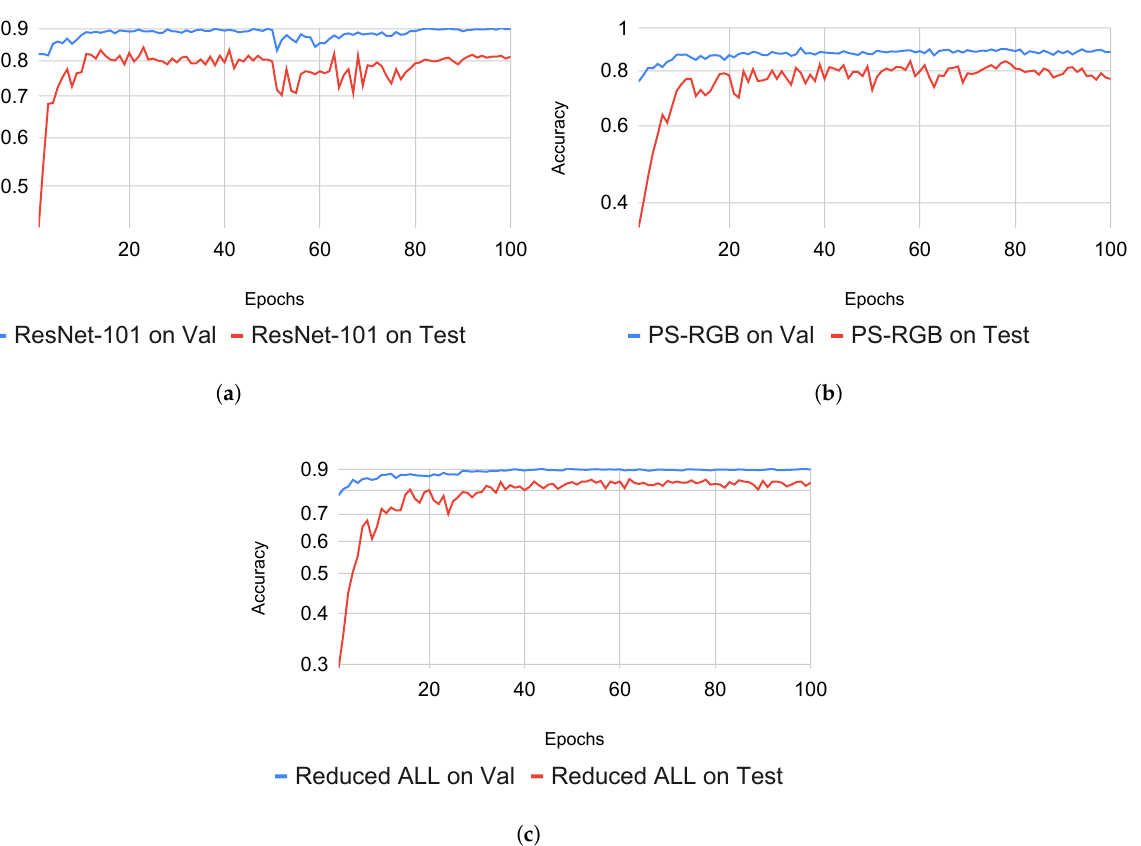
Figure 8. Comparisons of accuracy curves on validation set and balanced testing set of ( a ) ResNet-101, ( b ) PS-RGB, and ( c ) Reduced